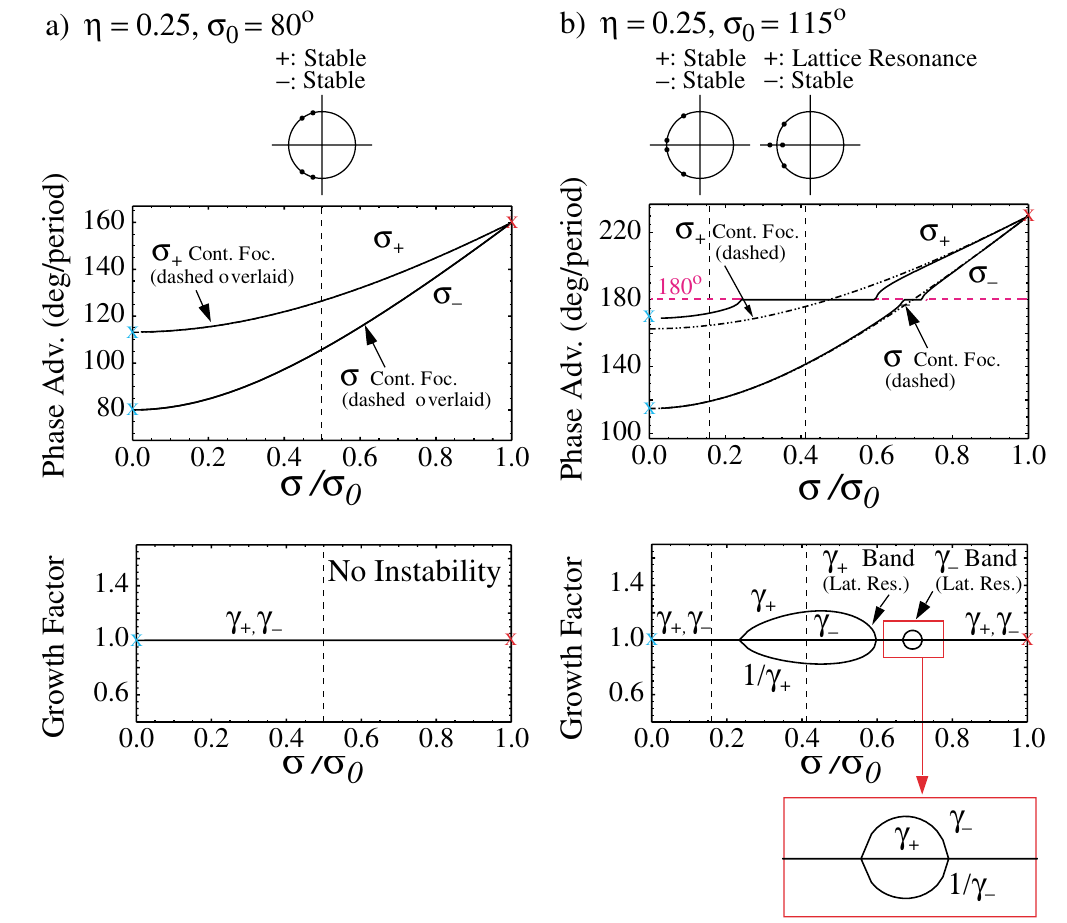
FIG. 13. (Color) Phase advance ( (cid:24) (cid:16) ) and growth factors ( (cid:6) (cid:16) ) of the breathing and quadrupole envelope modes versus (cid:24)=(cid:24) solenoidal focusing channel with occupancy (cid:31) (cid:1) 0 : 25 for (cid:24) predictions for (cid:24) (cid:16) are superimposed (dashed curves). Red (cid:22) s mark analytical results in the zero space-charge limit and cyan (cid:22) s mark thin-lens limit ( (cid:31) ! 0 ) analytical results with (cid:24)=(cid:24) eigenvalues (cid:14) (cid:16) placed above. Red boxes denote expanded